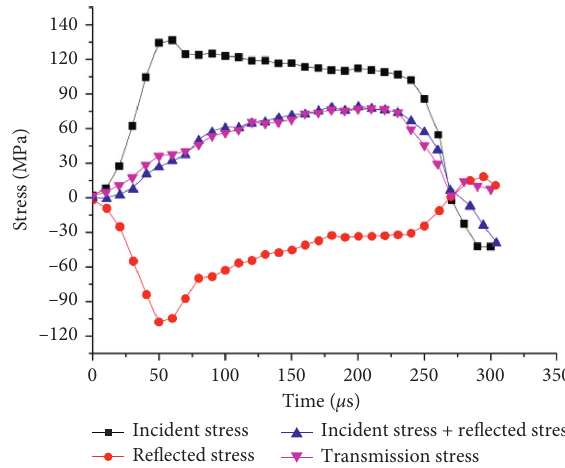
Figure 5: Stress balance test of sandstone specimen. Table 1: Uniaxial compressive strength of sandstone specimens with different degrees of